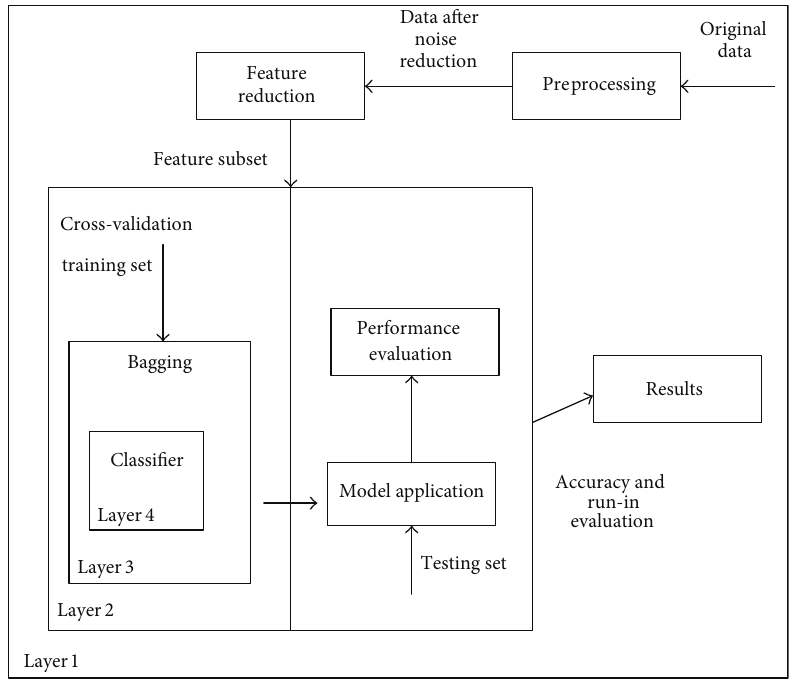
Figure 1: Design of global optimization ensemble model for classification methods